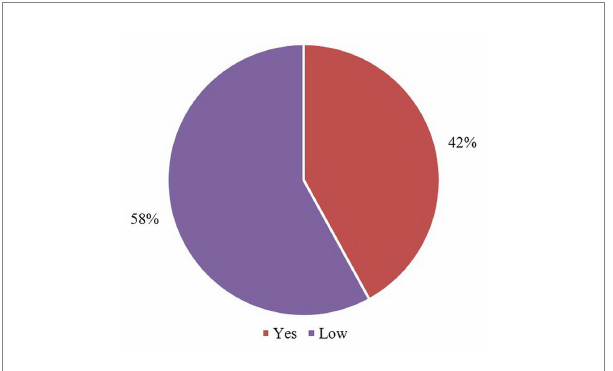
FIGURE 4 Answers to the question: are you familiar with Massive Open Online Courses (MOOCs)? Source: compiled by the authors.